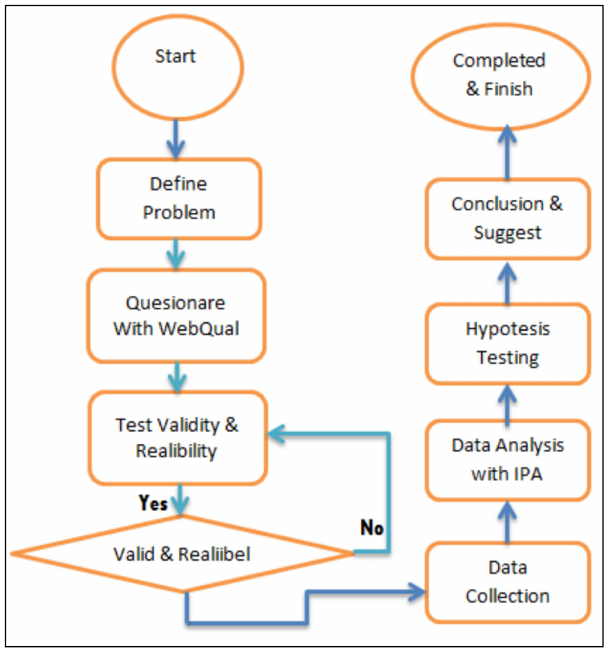
Fig.2 Research Thinking Framework [24